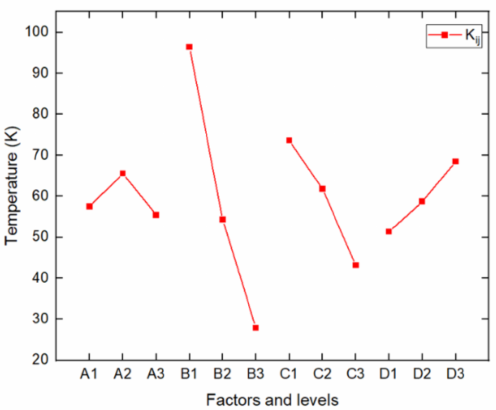
Figure 10. Relationship between temperature deviation and factor